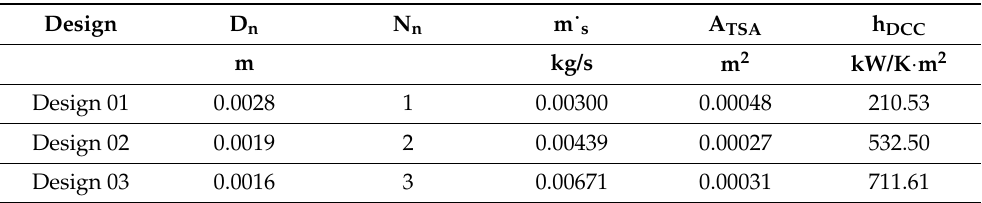
Table 4. Heat transfer coefficient for the geometry.